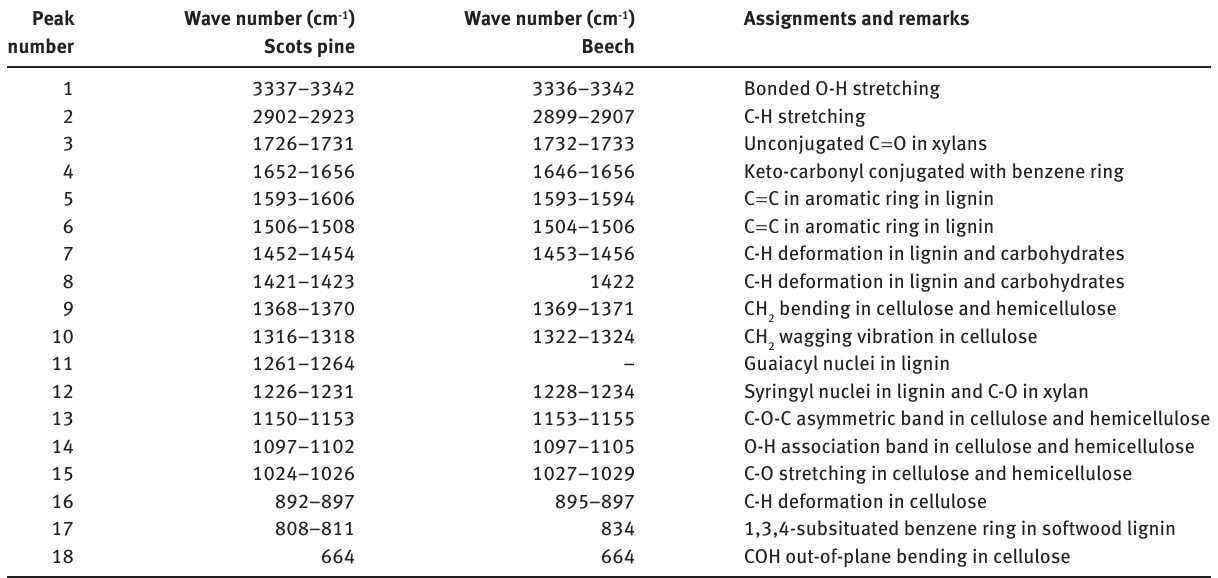
Table 1 Assignments of absorption infrared spectra bands in wood [25, 29, 36, 37] Peak